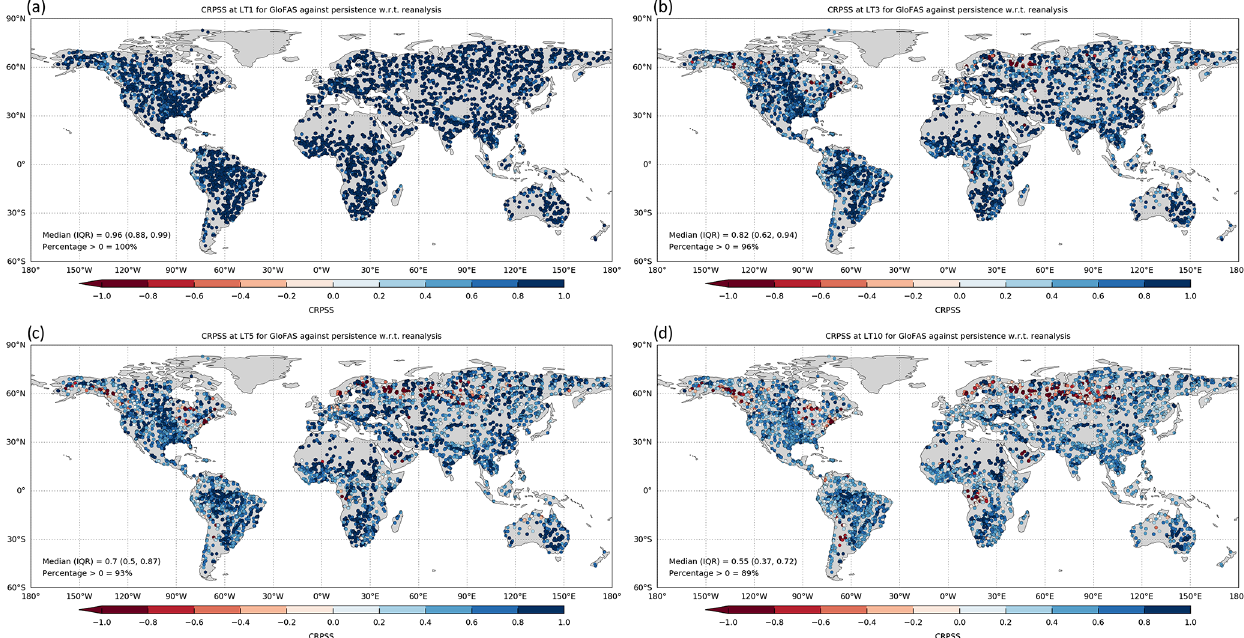
Figure 6. GloFAS 2.1/2.2 with continuous ranked probability skill score (CRPSS) for reforecasts against the persistence benchmark for short- to medium-range lead times – 1d (a) , 3d (b) , 5d (c) , and 10d (d) – with respect to GloFAS-ERA5 river discharge reanalysis at